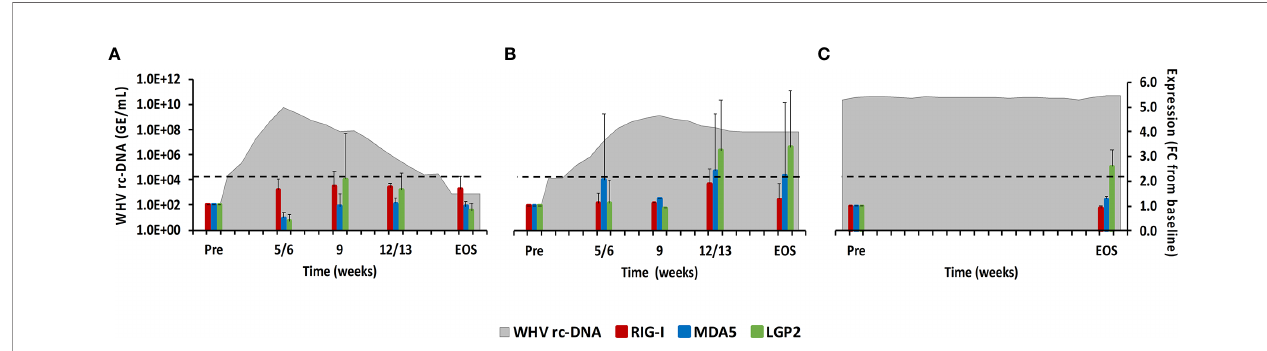
FIGURE 3 | Intrahepatic RLR expression. Expression changes of RIG-I, MDA5, and LGP2 in liver with WHV rc-DNA kinetics of woodchucks during (A) AHB with normal resolution (n=5), (B) AHB with delayed resolution (n=5), and (C) CHB progression (n=3). The fold-changes in receptor transcript level are plotted on the right y-axis, while serum WHV rc-DNA loads are plotted on the left y-axis. The horizontal, dotted line indicates the cutoff for positive expression (i.e., ≥ 2.1-fold increase from the pre-inoculation baseline). Horizontal bars represent the standard error of the mean. Pre, pre-inoculation for AHB and start of study for CHB; EOS, end of study; FC, fold-change.